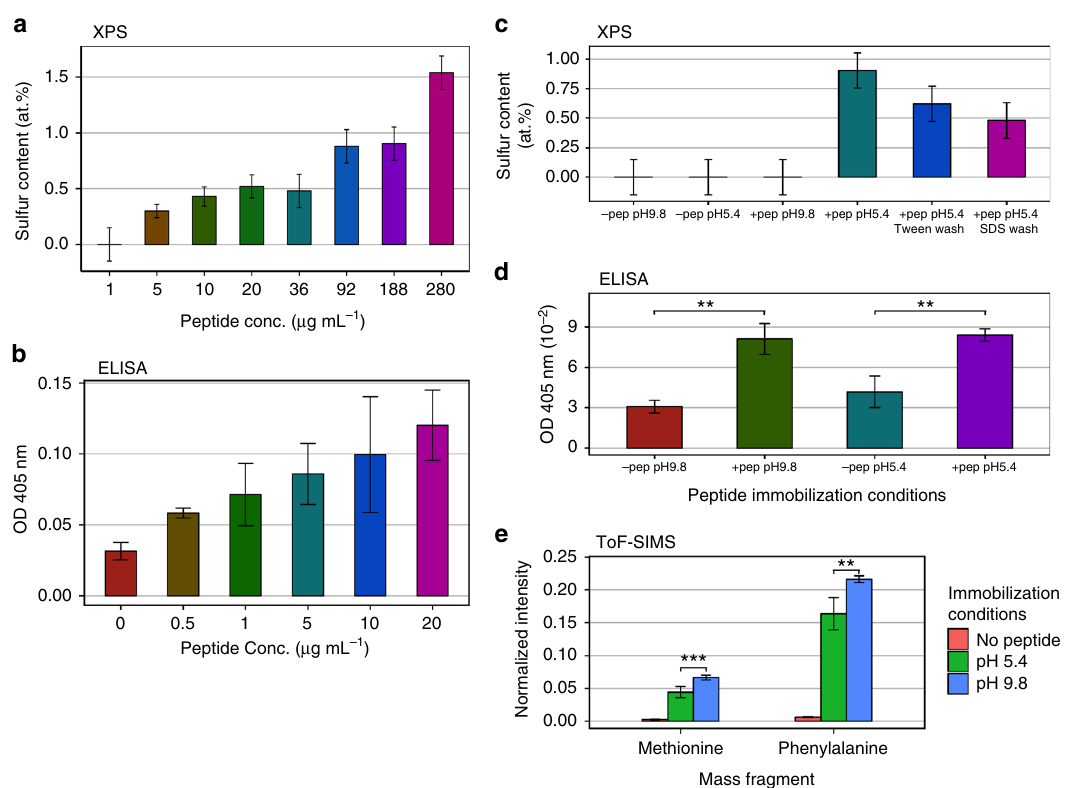
Fig. 4 pH controls the peptide concentration and orientation. a Sulfur content, as measured by X-ray photoelectron spectroscopy (XPS), indicates increasing surface peptide with solution concentration but is undetectable for concentrations below 5 µ g mL − 1 . b Peptide titration shows that enzyme-linked immunosorbent assay (ELISA) is discriminatory for peptide concentrations down to at least 0.5 µ g mL − 1 but saturates at approximately 20 µ g mL − 1 due to the large footprint of the primary and secondary antibodies compared to the peptide. Hence, ELISA is not capable of discerning immobilized peptide surface density for high densities while XPS is not capable of detecting low peptide surface concentrations. c XPS sulfur atomic concentration of peptide-coated surfaces compared to uncoated controls for immobilization pH values of 5.4 and 9.8. The sulfur content shows surface peptide at pH 5.4, but no detectable peptide at pH 9.8. Presence of peptide after Tween 20 or sodium dodecyl sulfate (SDS) washing indicates covalent attachment. d The absorbance measured with ELISA for peptide-coated samples for immobilization pH values of 5.4 and 9.8 compared with uncoated controls. ELISA shows that peptide is present at both pH values. e Time of fl ight secondary ion mass spectrometry (ToF-SIMS) normalized mass fragments of the hydrophobic residues indicate higher number of FLAG DOWN peptide for pH 9.8, suggesting that a greater proportion of peptide for pH = 5.4 is in the FLAG UP orientation. Error bars are s.d. and P -values are from the Student ’ s two-tailed t -test: ** P < 0.01, *** P < 0.001 ( b , d and e ). XPS error bars are calculated from the